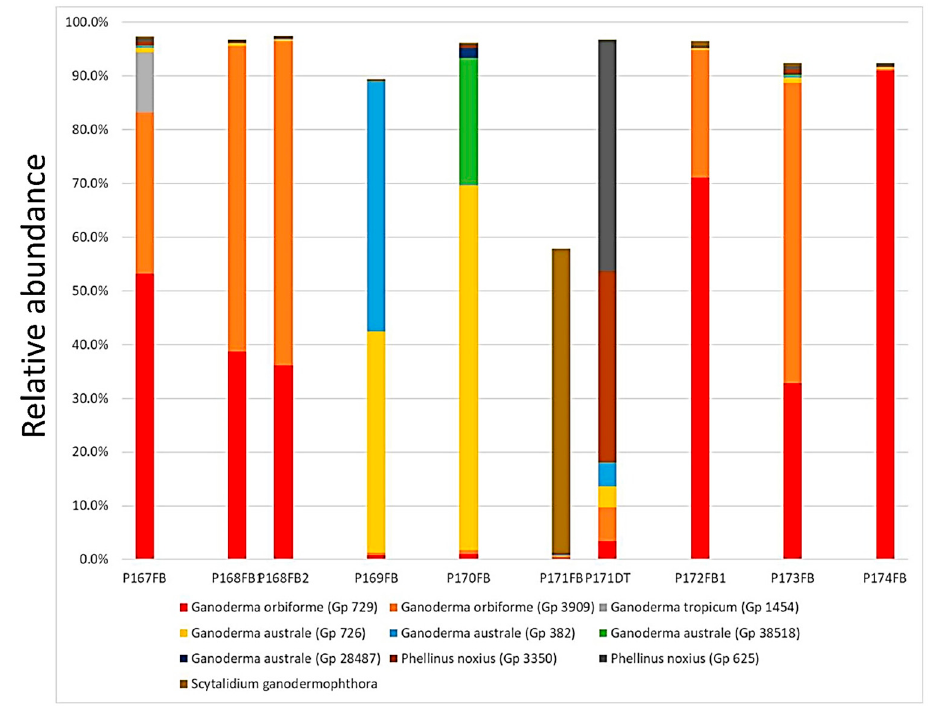
Figure 7. Genetic heterogeneity in Ganoderma fruiting bodies. Multiple fruiting body samples were subjected to a metagenomics analysis and the relative abundance of OTUs is represented in the bar chart as a percentage of the total sequence reads for the sample. GenBank accession numbers: